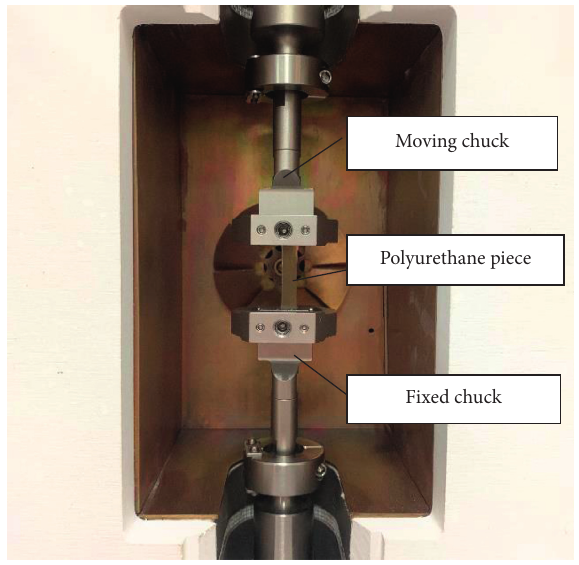
Figure 2: Static tension of the polyurethane piece.